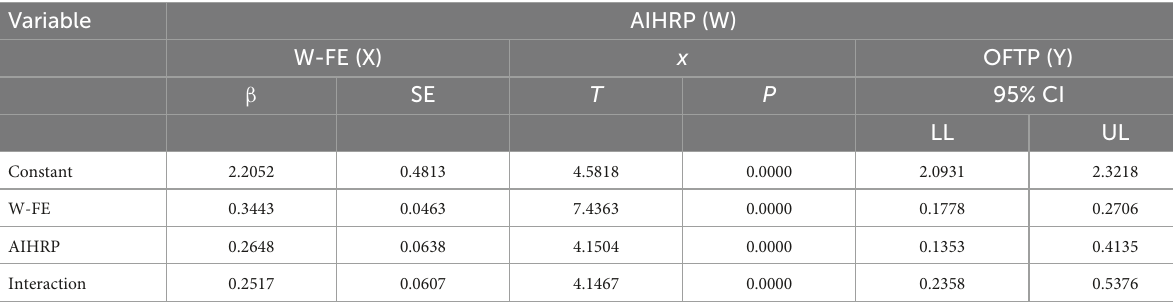
TABLE 6 Moderated mediation model results.